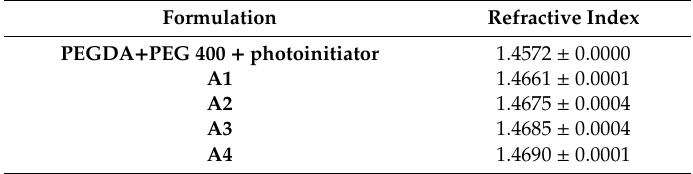
Table 4. Refractive index of the placebo and the ATH formulations (mean value ±